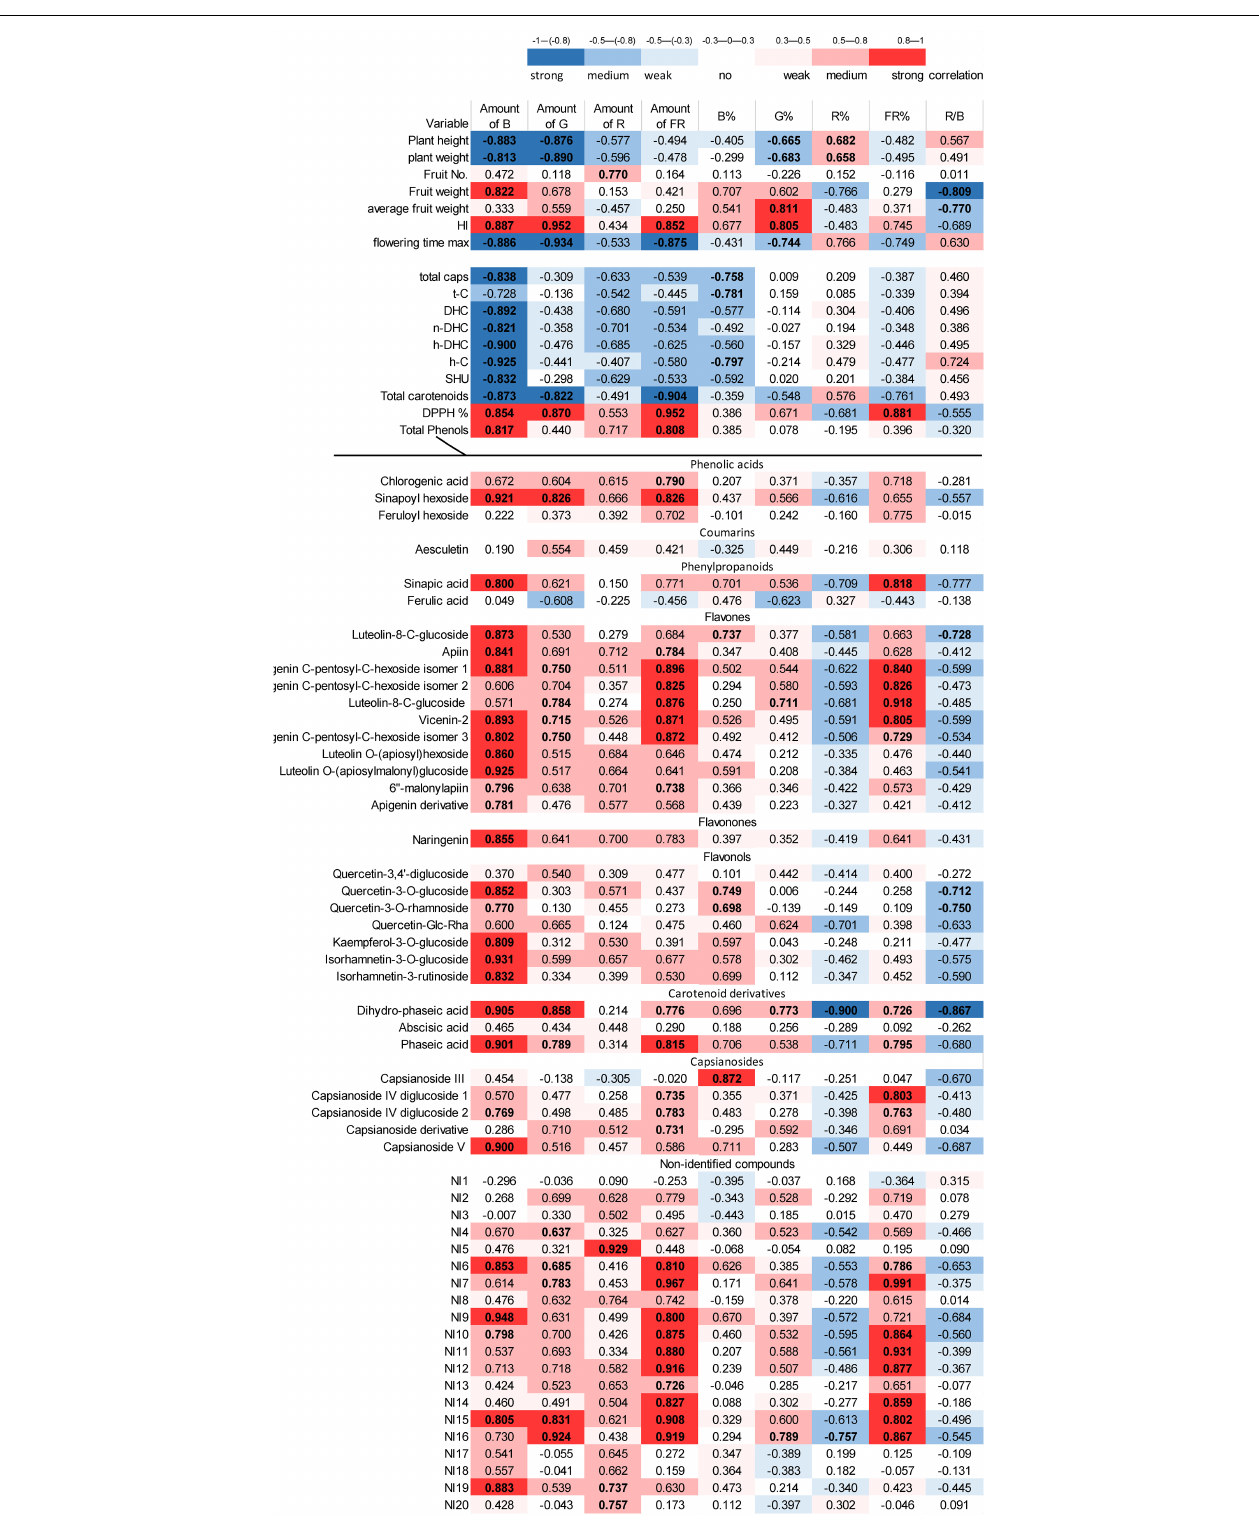
FIGURE 4 | Correlation analysis between the light conditions and all studied parameters of chilli. The absolute and relative amounts of different light regions were integrated daily (DLI) and used as indicated in Table 1 . The blue colour indicates negative (inverse), whereas red colour represents positive (direct) correlations, and more intense colour shows higher correlation. The “r” values are also presented. The bold values show the significance level at the p < 0.05 level.